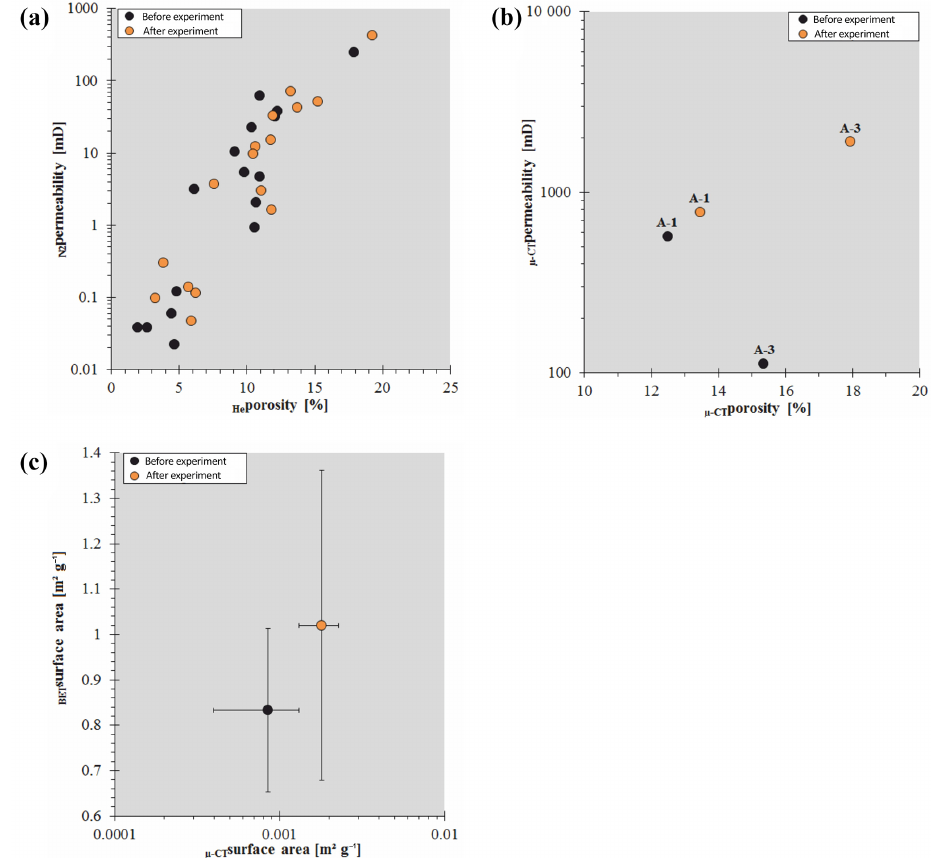
Figure 6. In (a) the helium porosity and nitrogen permeability measurement results of 16 Permian samples before and after CO 2 experiments are presented (data from Pudlo et al., 2012). In (b) the µ -CT porosity and µ -CT permeability data for two Permian cube samples before and after the CO 2 experiments are shown. In (c) the mean values of the measured BET surface areas (six samples) and the calculated µ -CT surface areas (four samples) before and after the CO 2 experiments are